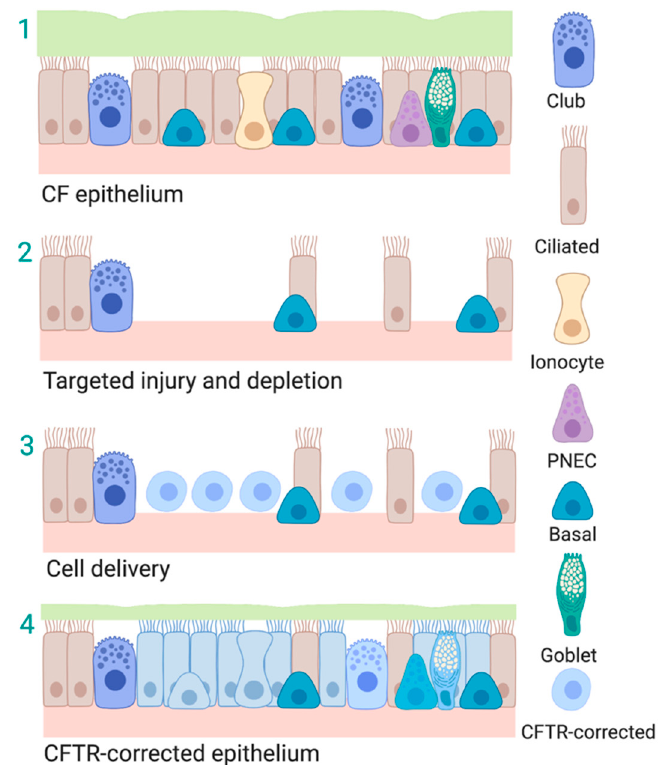
Figure 1. Schematic of cell-based replacement therapy for Cystic Fibrosis. Cell-replacement therapy in which defective airway epithelium (1) is ablated via injury to the airways thereby creating a niche for engraftment (2). Corrected cells are then delivered into the airways, localize and engraft in the exposed niche (3) and restore functional epithelium (4). Figure created with BioRender.com.